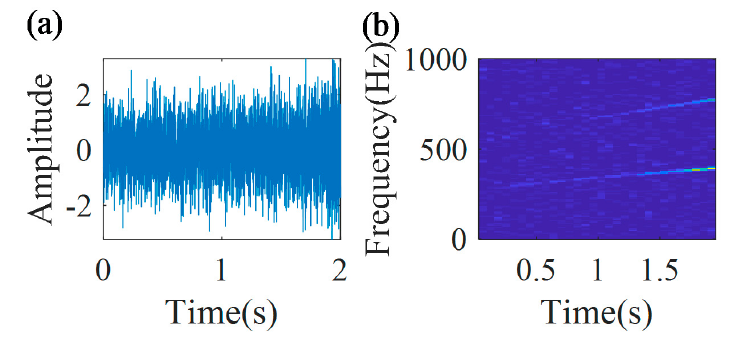
Figure 14. ( a ) Multi-component signal; and ( b ) its TFR.